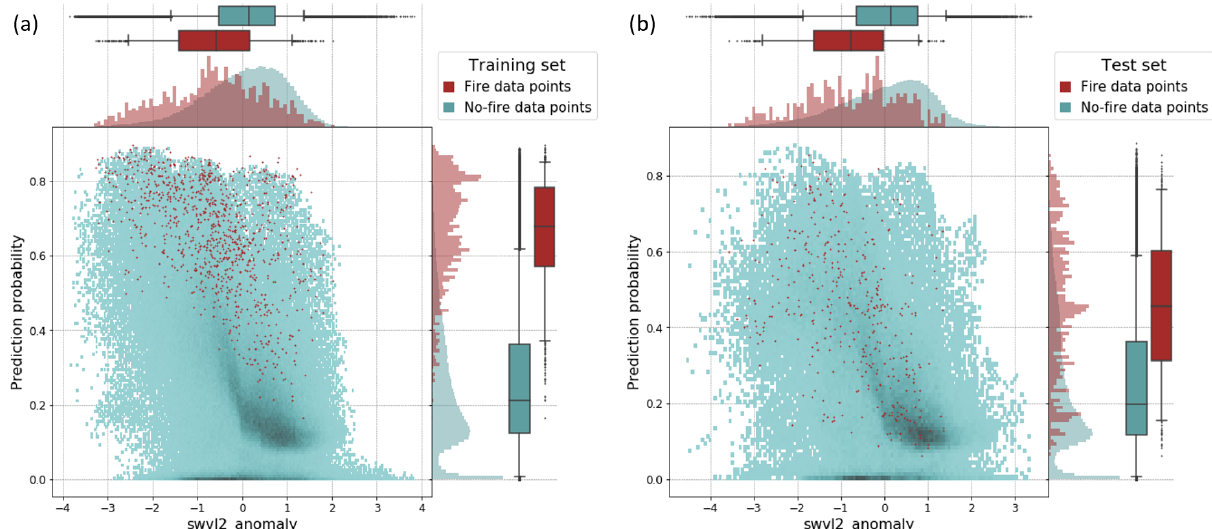
Figure 7. The bivariate and univariate distributions of the anomaly in volumetric soil water in soil layer 2 (swvl2_anomaly) and predicted fire danger probabilities. Results are shown for (a) the training set and (b) the test set. The distributions are given separately for the fire data points (red) and no-fire data points (blue) from the satellite-based target variable. The histograms show the relative frequencies, and the box plot whiskers define the 5th–95th percentile